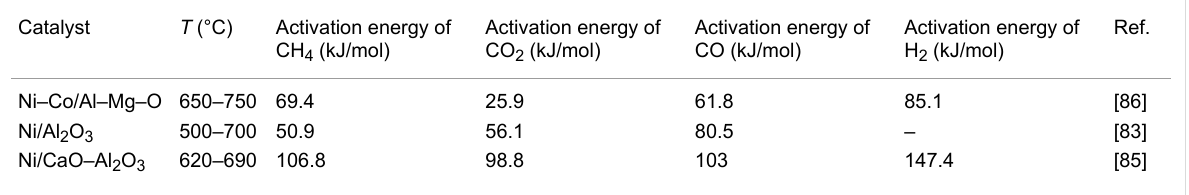
Table 2: Activation energies of various catalysts